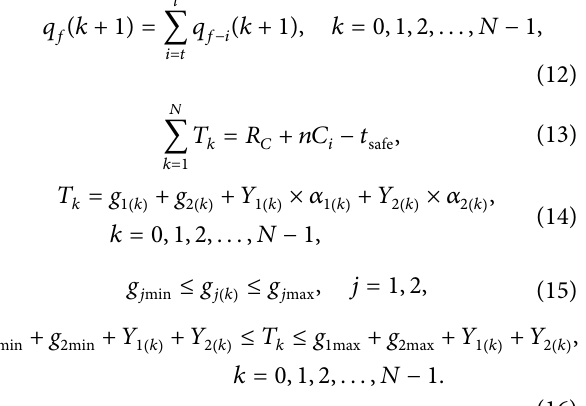
Figure 2: Four gene positions per time